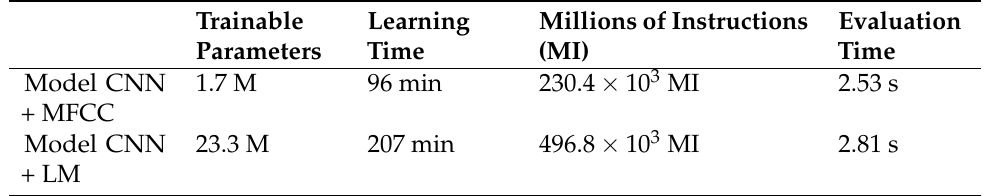
Table 4. Trainable parameters, learning time, millions of instructions (MI), and evaluation time.